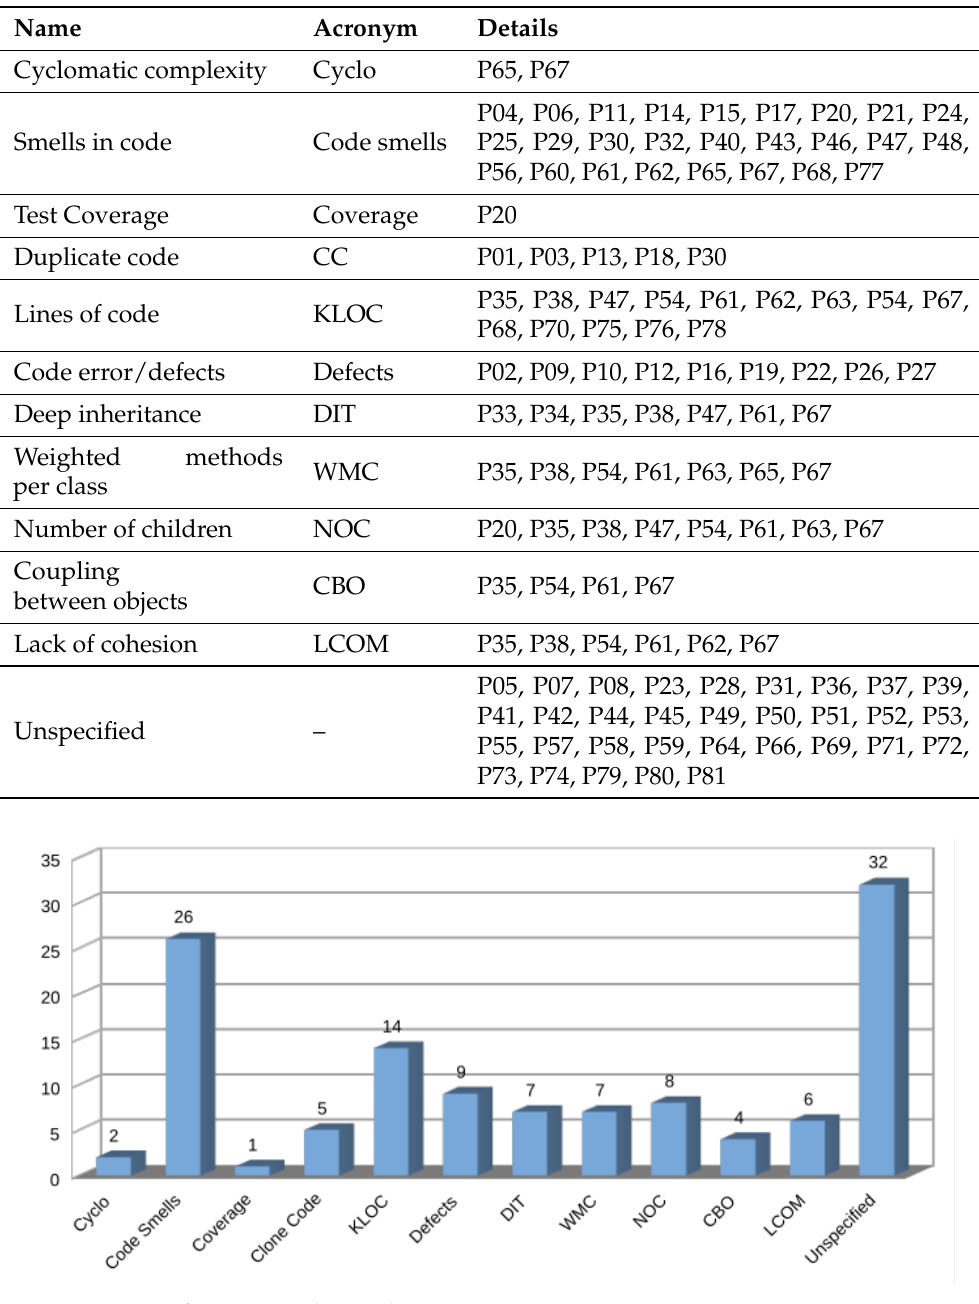
Table 9. Details of identified metrics.